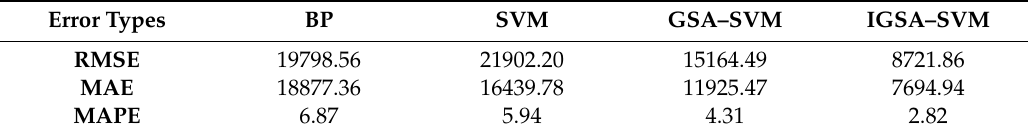
Table 3. Error analysis and comparison.